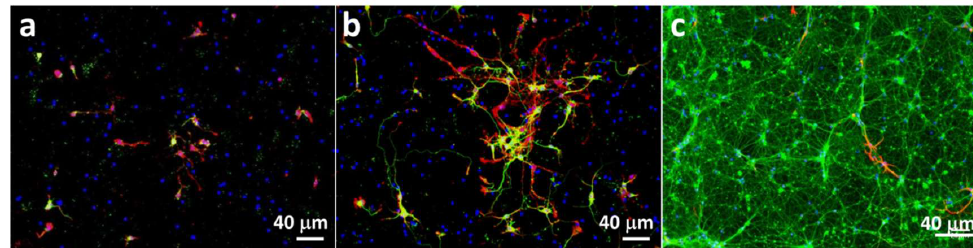
Figure 1. Immunofluorescence images of neuroprogenitor cells after different culture times: ( a ) 1 day, ( b ) 3 days and ( c ) 14 days. β actin is represented in red (a, b); βIII Tubulin in green (a–c) and glial fibrillary acidic protein (GFAP) in red (c).